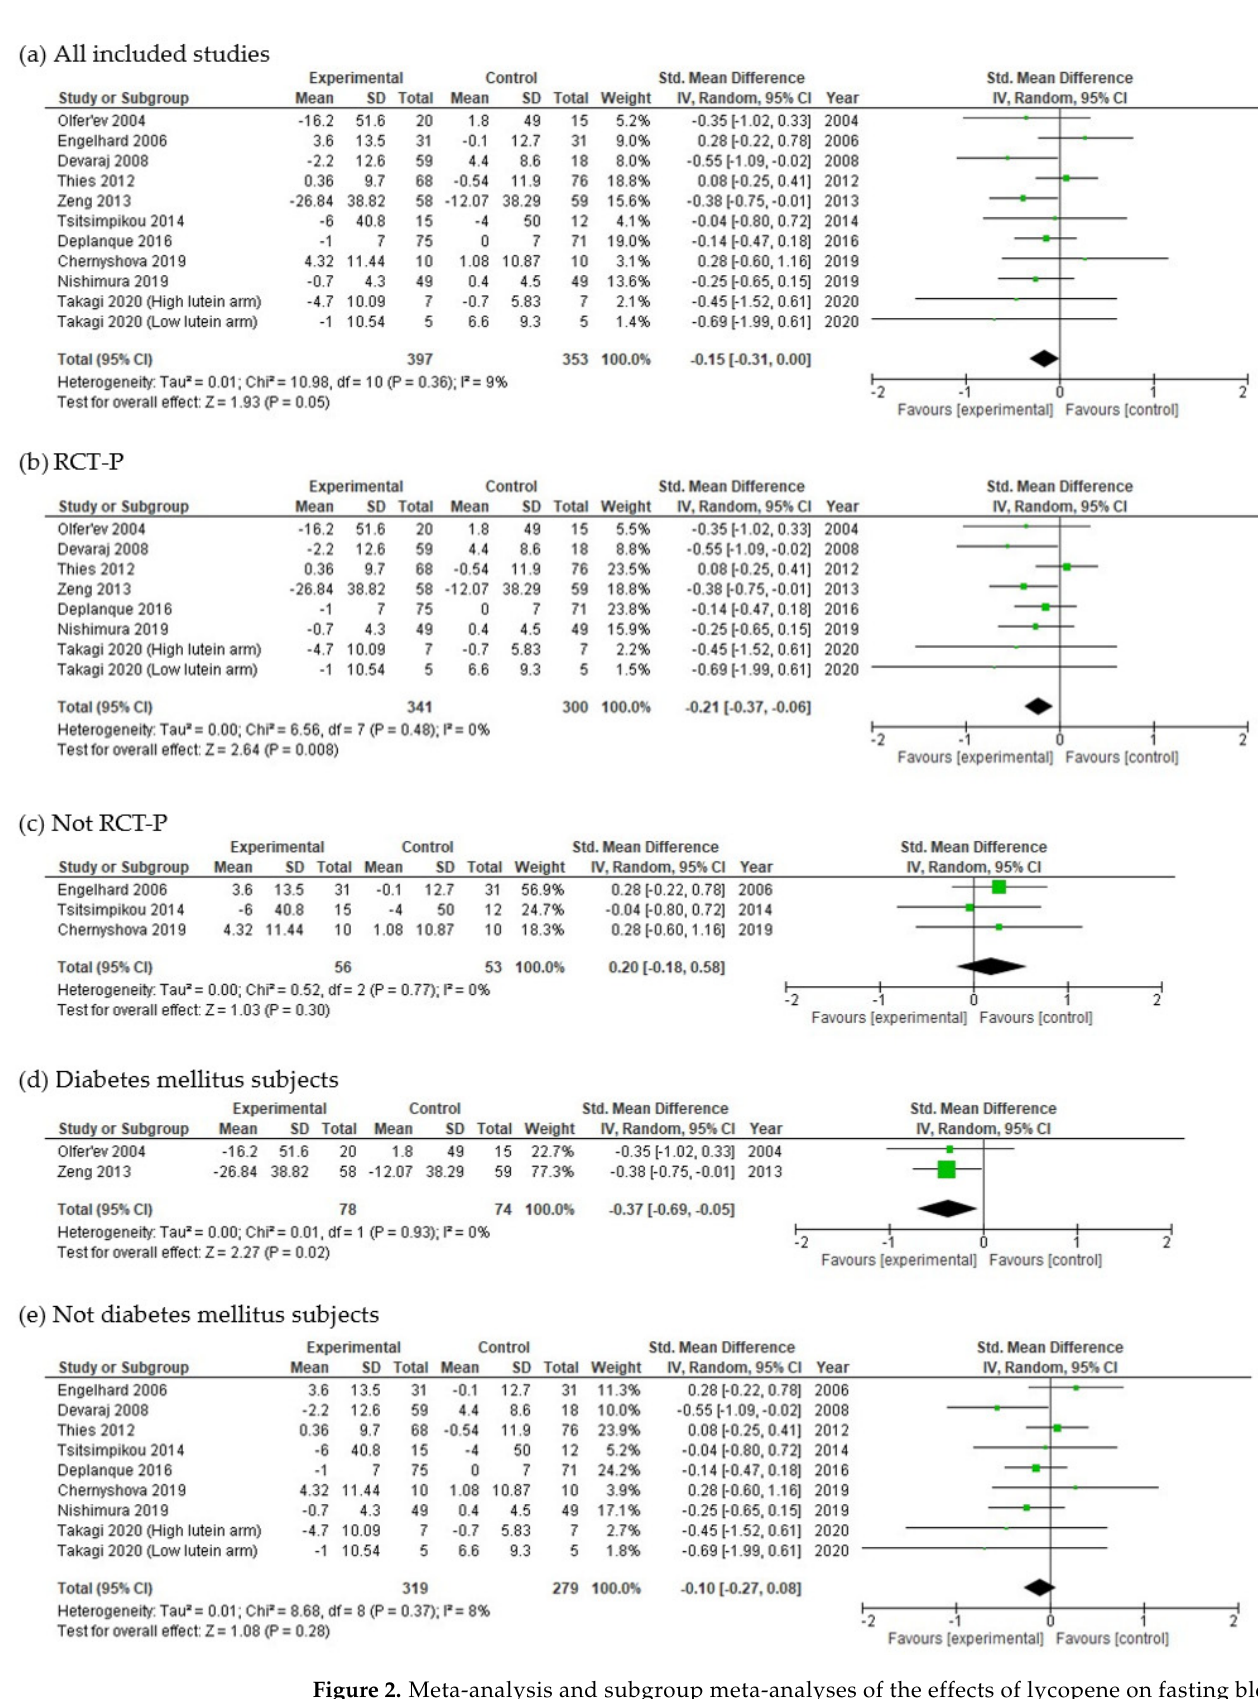
Figure 2. Meta-analysis and subgroup meta-analyses of the effects of lycopene on fasting